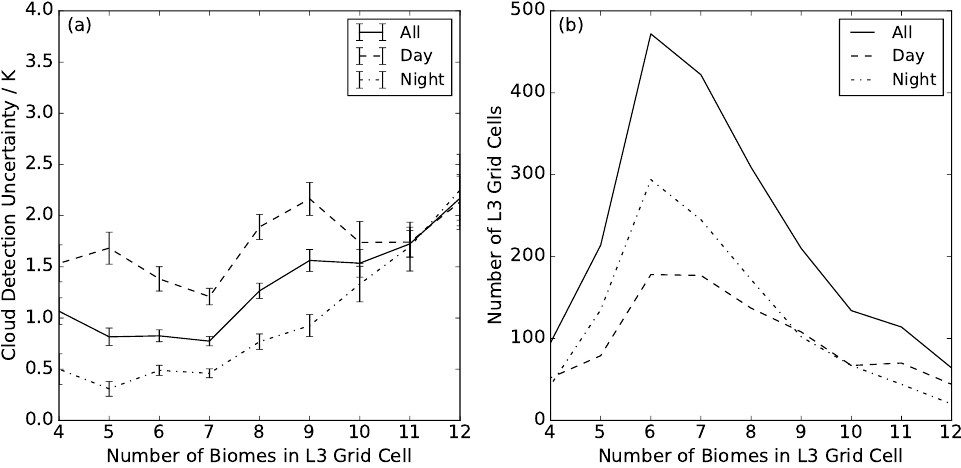
Figure 9. Cloud detection uncertainties as a function of number of biomes in each grid cell ( a ) at 625-km 2 resolution. The following are shown: all data (solid line), night-time only (dot-dash line) and daytime only (dashed line). Panel ( b ) shows the number of observations in each